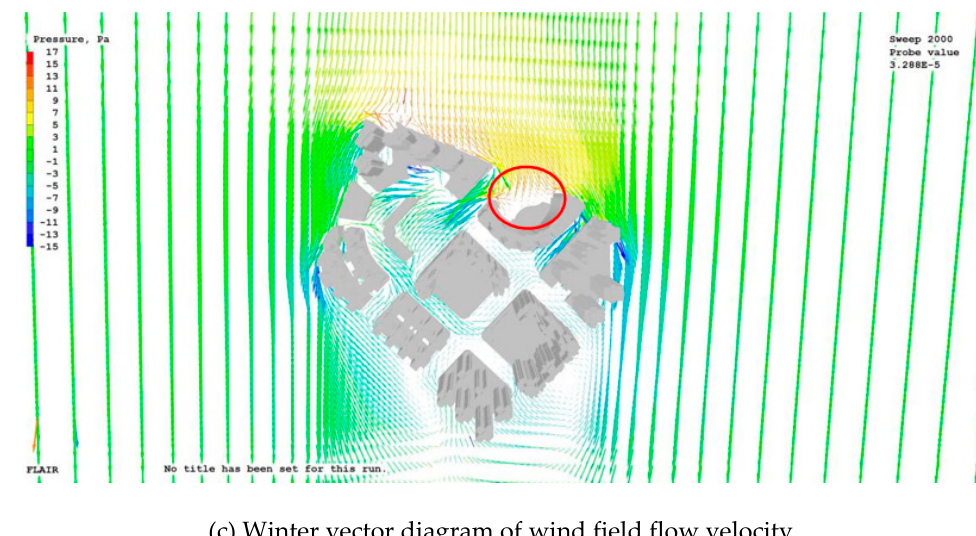
Figure A4. Winter vector diagram, winter wind field pressure vector diagram, and winter vector diagram of wind field flow velocity at 1.5 m height.